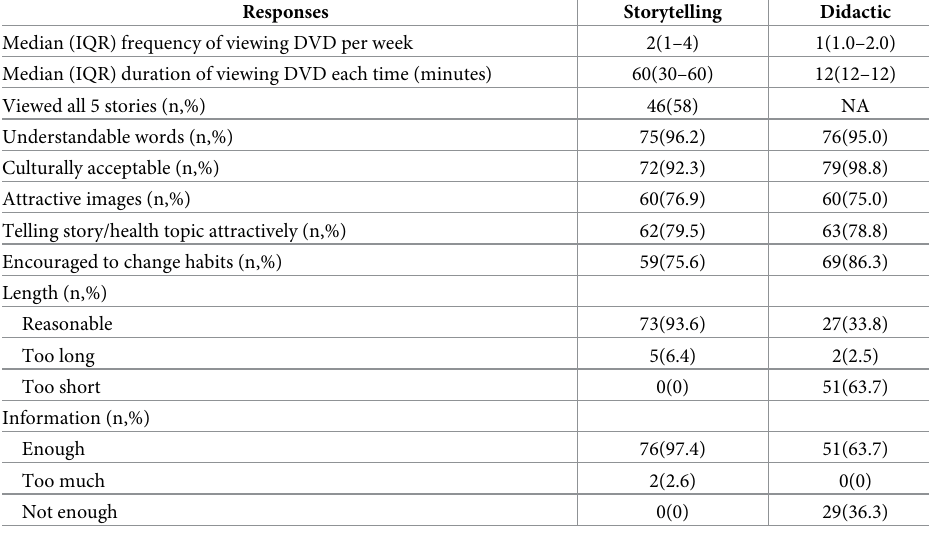
Table 2. Post second DVD viewing survey according to intervention condition. Responses